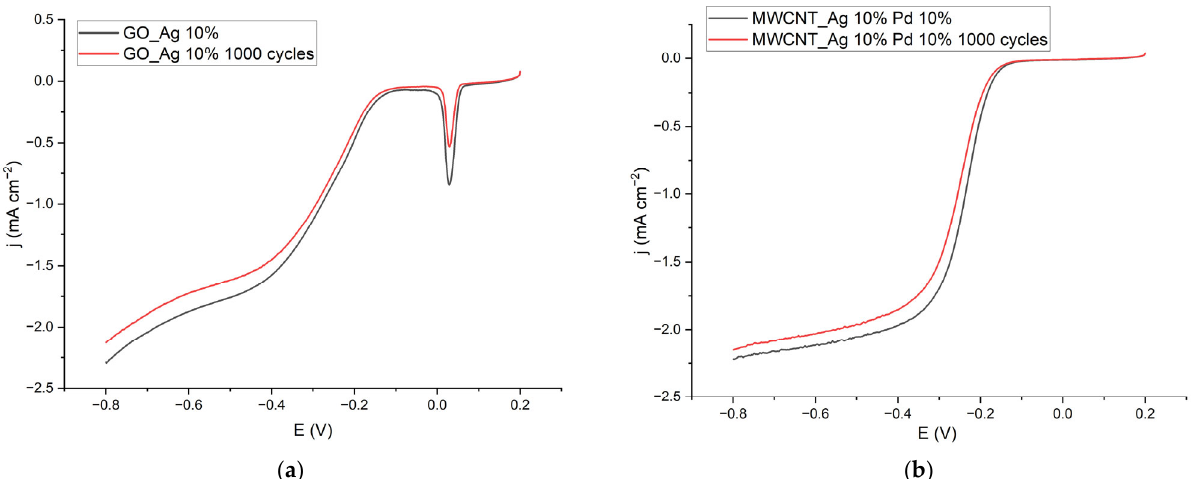
Figure 10. Corrosion testing of the most active catalysts: ( a ) GO Ag 10%, ( b ) MWCNT_Ag 10% Pd